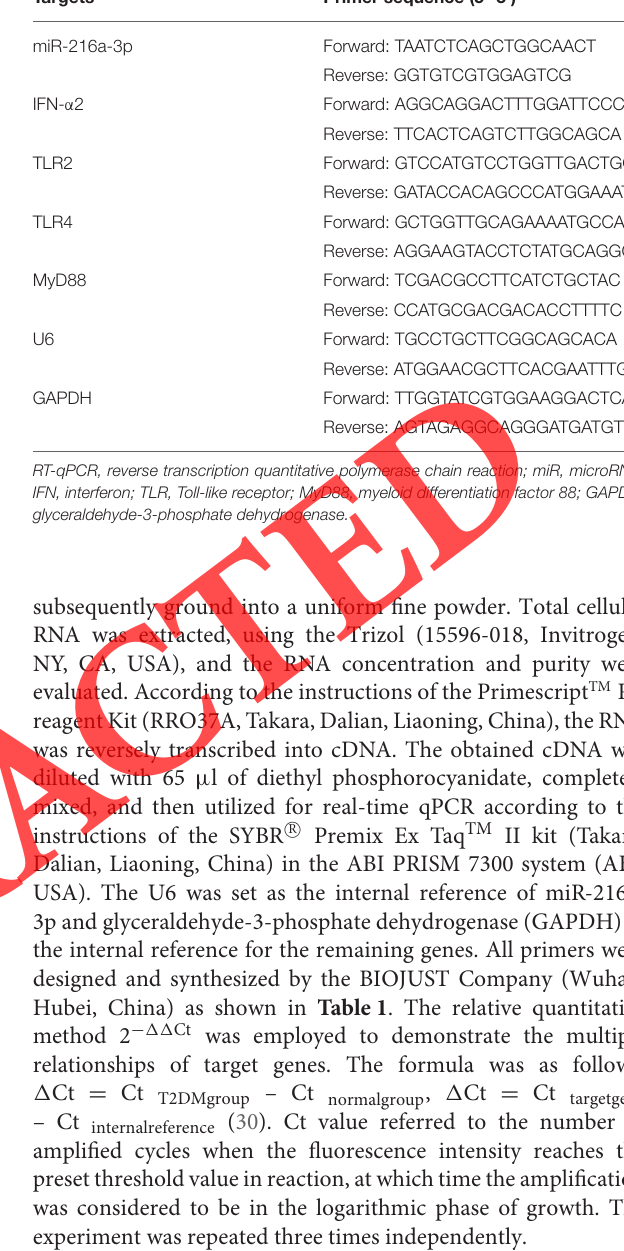
TABLE 1 | Primer sequences of related genes for